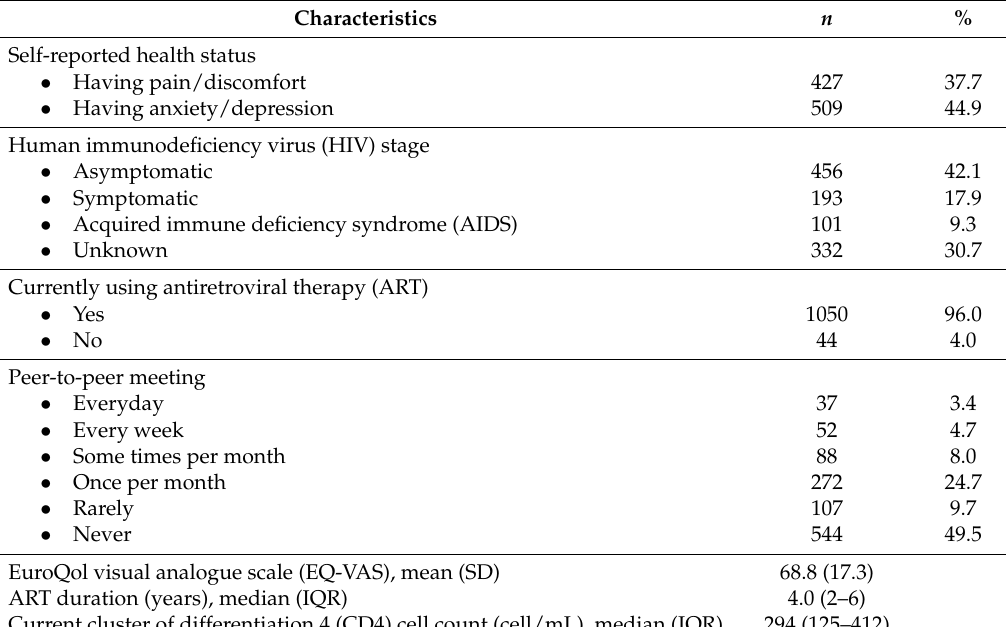
Table 2. Clinical characteristics and health status of participants ( n = 1133).